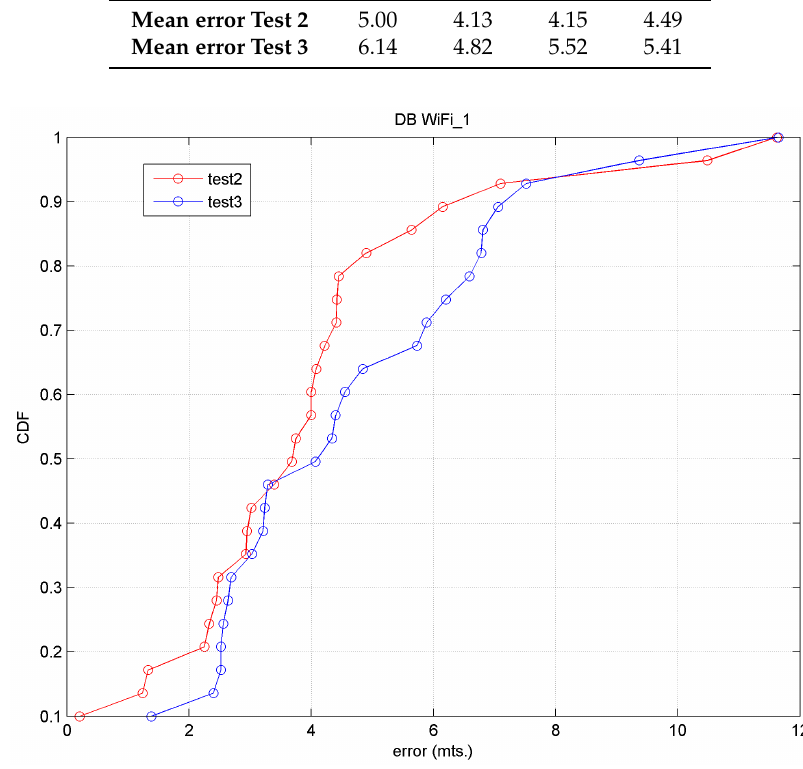
Figure 12. Precision (CDF) for Test 2 and Test 3.